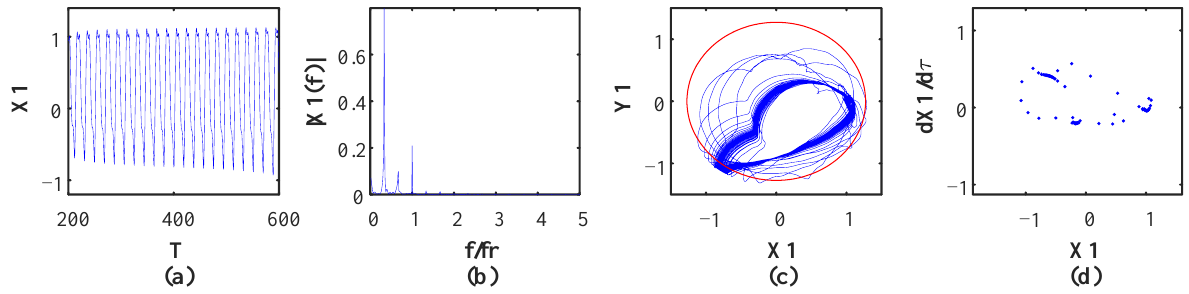
Figure 12. Numerical integration results at ω = 1308 rad/s: ( a ) Time domain waveform; ( b ) Frequency spectrum; ( c ) Shaft orbit; ( d ) Poincaré map.